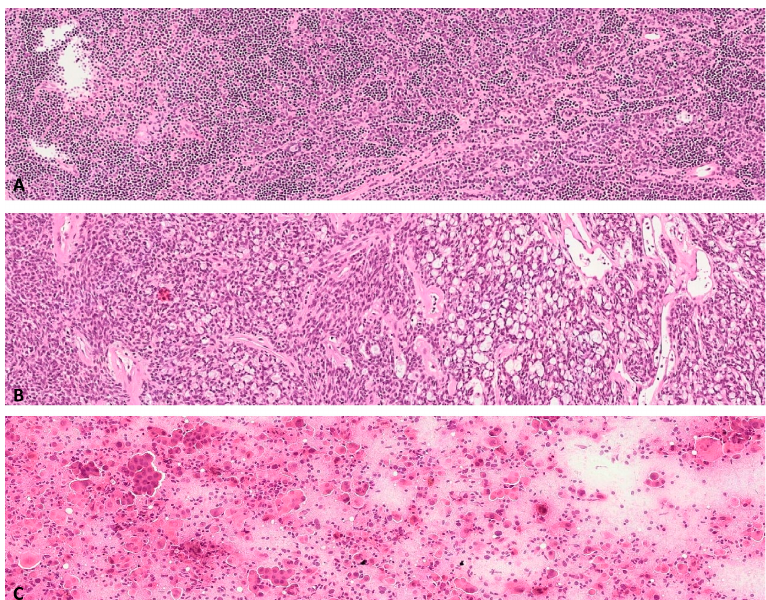
Figure 2. Epithelioid proliferation associated to lymphoid tissue on frozen sections from mediastinal lesions ( A , B : Ematoxylin/eosin, 20×) and hypercellular smear with carcinomatous aggregates from the pulmonary mass ( C : Ematoxylin/eosin, 30×).